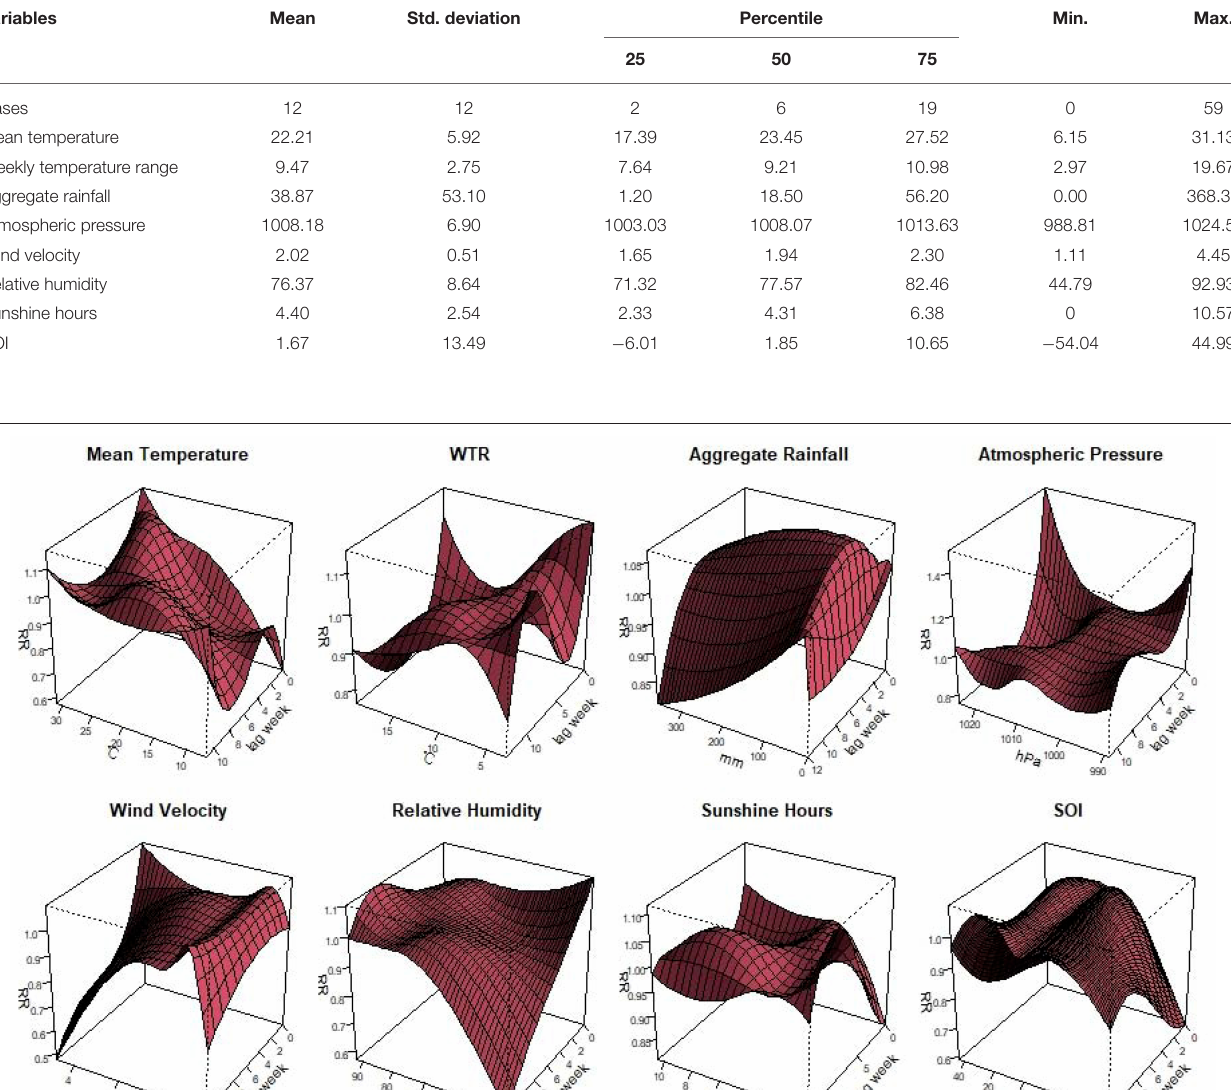
TABLE 1 | Weekly meteorological factors, SOI and scrub typhus cases in Guangzhou,